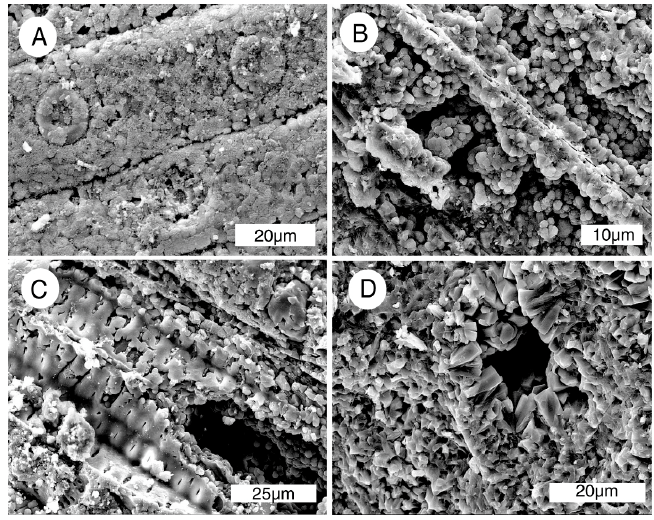
Figure 11. SEM photomicrographs of Bruneau Woodpile wood show microcrystalline structure of carbonate-fluorapatite. ( A ) Longitudinal view of two tracheids showing circular pits; ( B ) Fractured cell walls of a tracheid; ( C ) Interior surface of a tracheid showing numerous pit apertures; ( D ) Carbonate-fluorapatite crystals bordering a pit aperture.